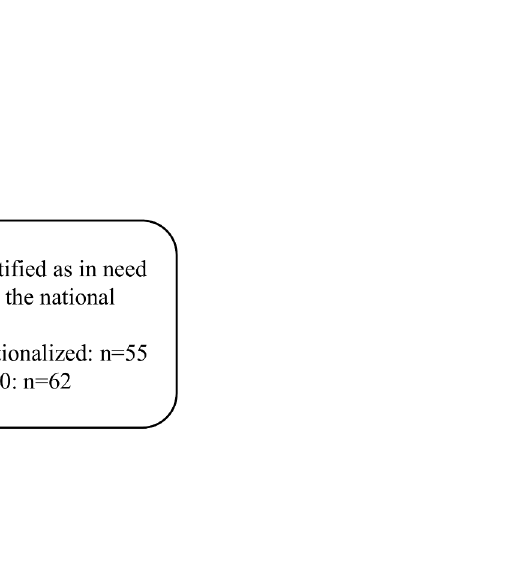
PLOS ONE | DOI:10.1371/journal.pone.0137656 September 11,